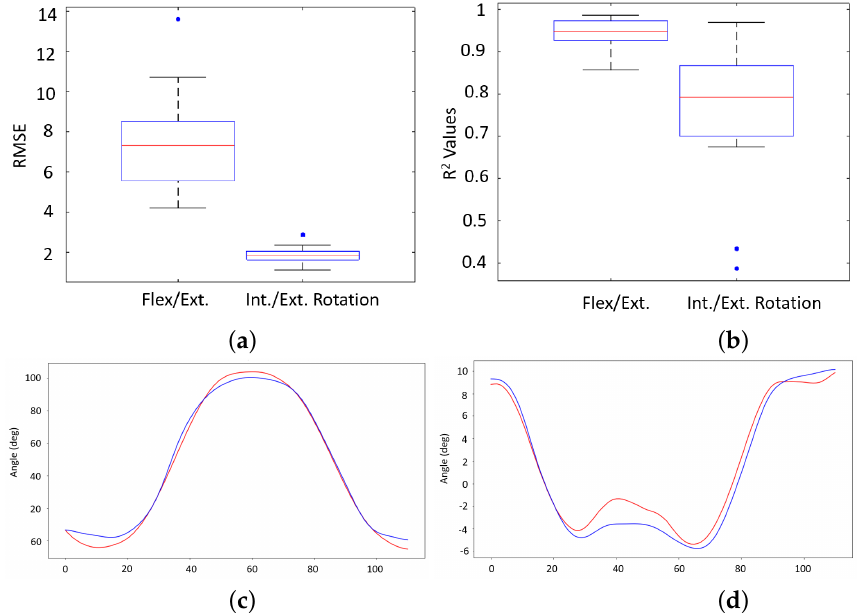
Figure 7. ( a , b ) show the distribution of the best model’s RMSE and R 2 value in both degrees of freedom for subject-specific models. Red bars denote the overall average and whiskers denote standard deviations of the dataset. Samples of the models’ outputs (red) and actual knee angles (blue) are also shown. Positive angles correspond to knee flexion and internal rotation. ( c , d ) show representative data from one trial. ( a ) RMSE. ( b ) R 2 . ( c ) Predicted (red) versus actual (blue) flexion/ extension knee angle. ( d ) Predicted (red) versus actual (blue)internal/external rotation angle.